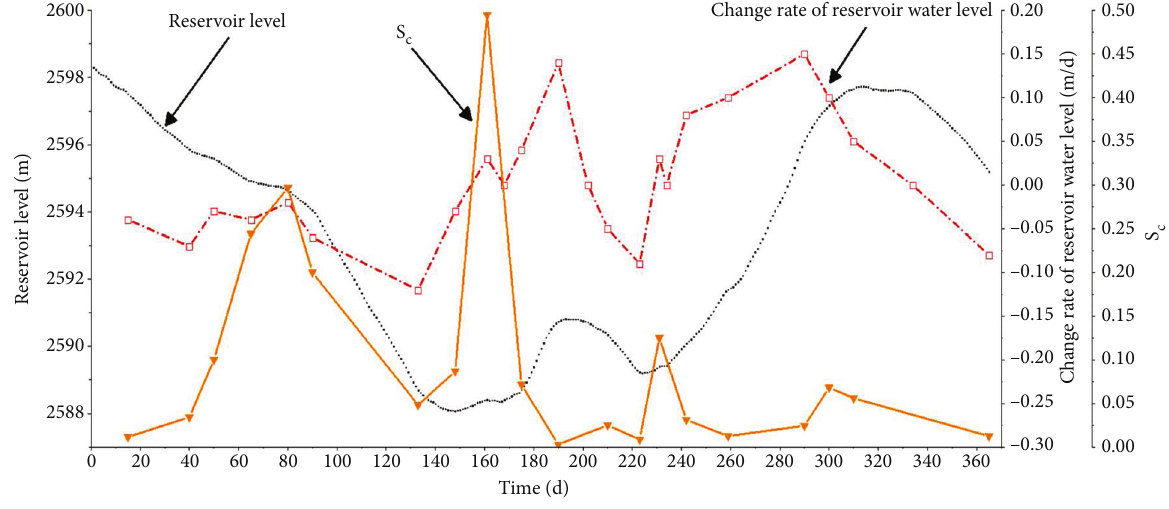
Figure 13: Calculation results of stability hysteresis coe ffi